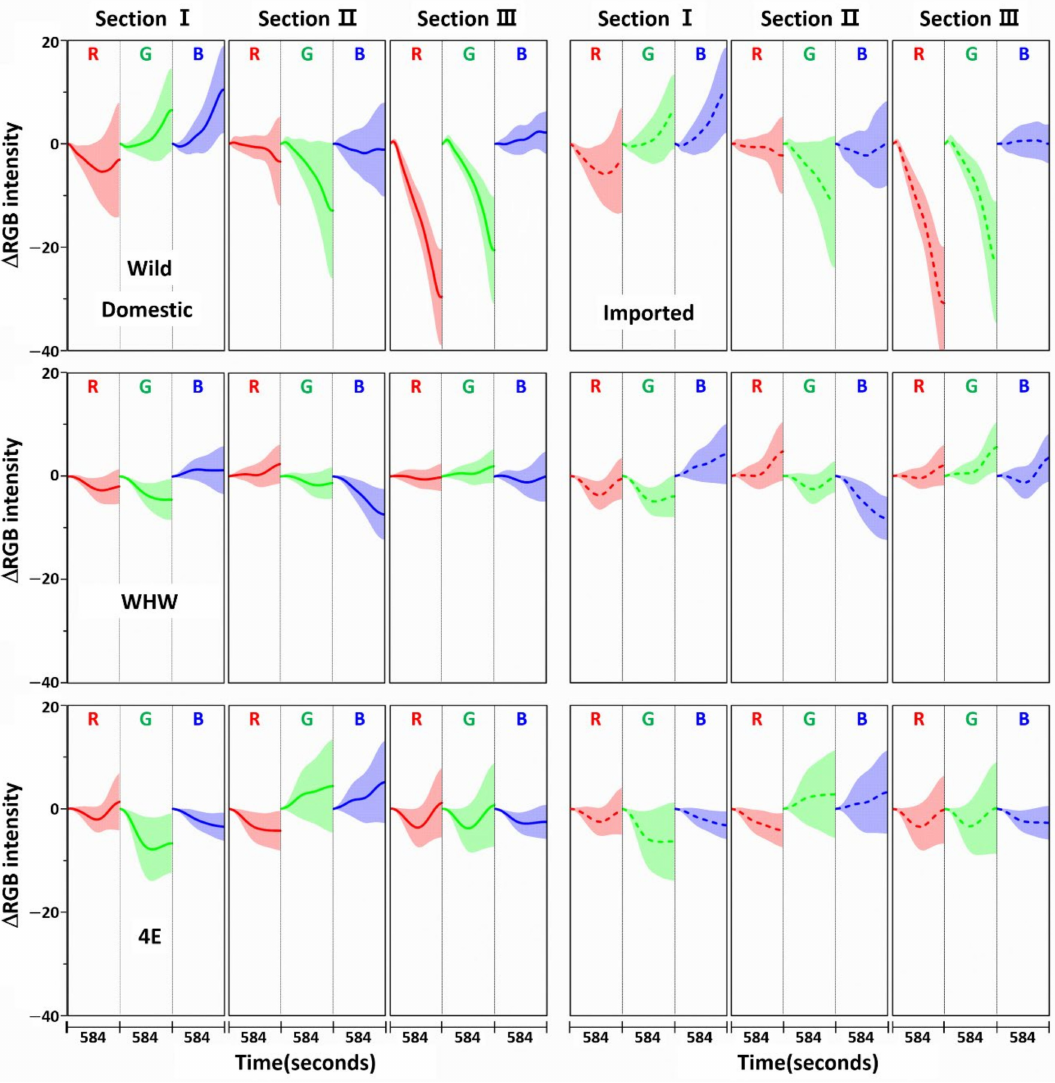
Figure 10. The same ∆ RGB intensities shown in Figure 9 with standard deviation (shading) for the domestic (left plot) and imported samples (right